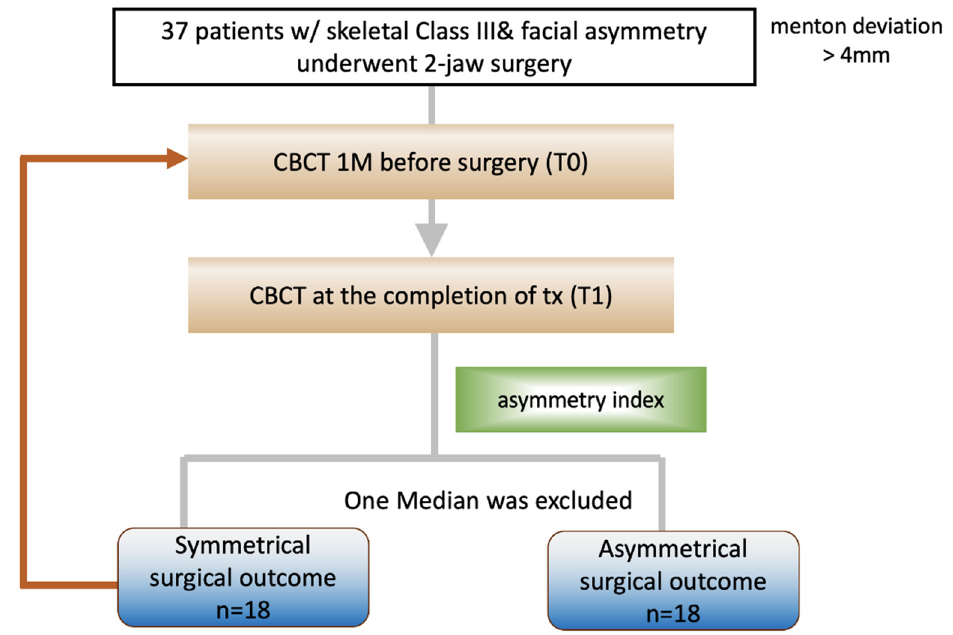
Figure 8. Flow chart for research design.